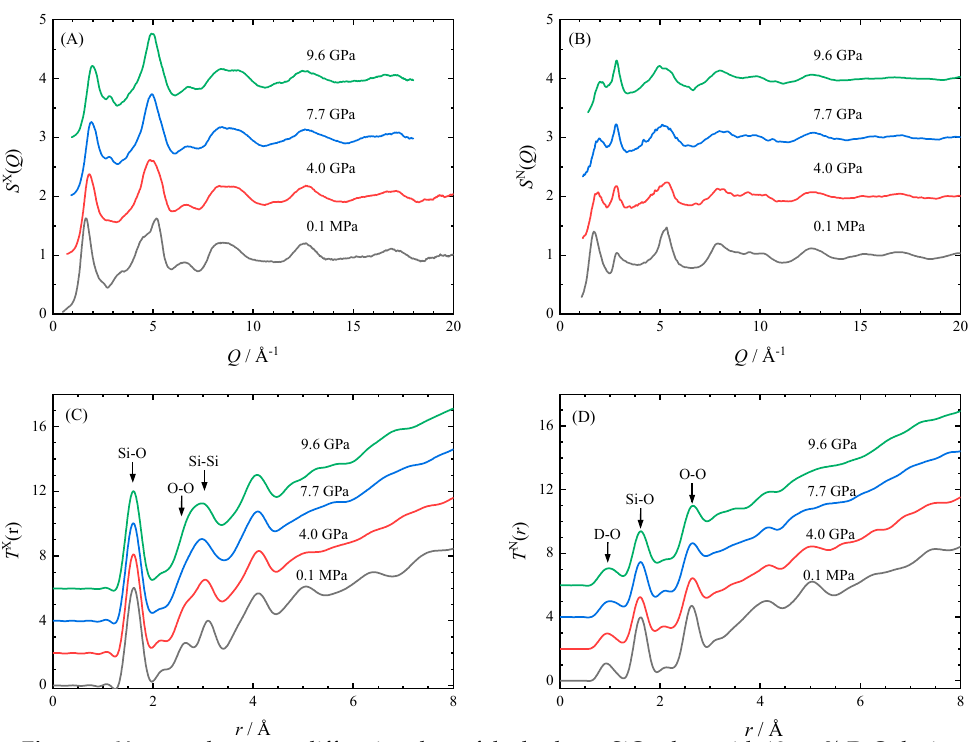
Figure 5. X-ray and neutron diffraction data of the hydrous SiO 2 glass with 13 wt.% D 2 O during room temperature compression to 10 GPa. ( A ) The X-ray structure factor S X ( Q ), ( B ) the neutron structure factor S N ( Q ), ( C ) the X-ray total correlation function T X ( r ), and ( D ) the neutron total correlation function T N ( r ).